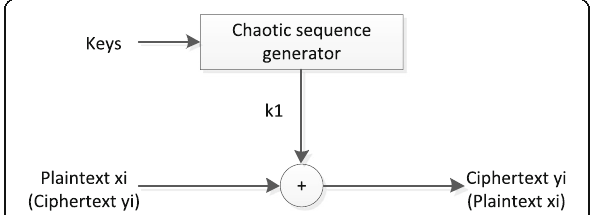
Fig. 1 Chaotic system encryption block